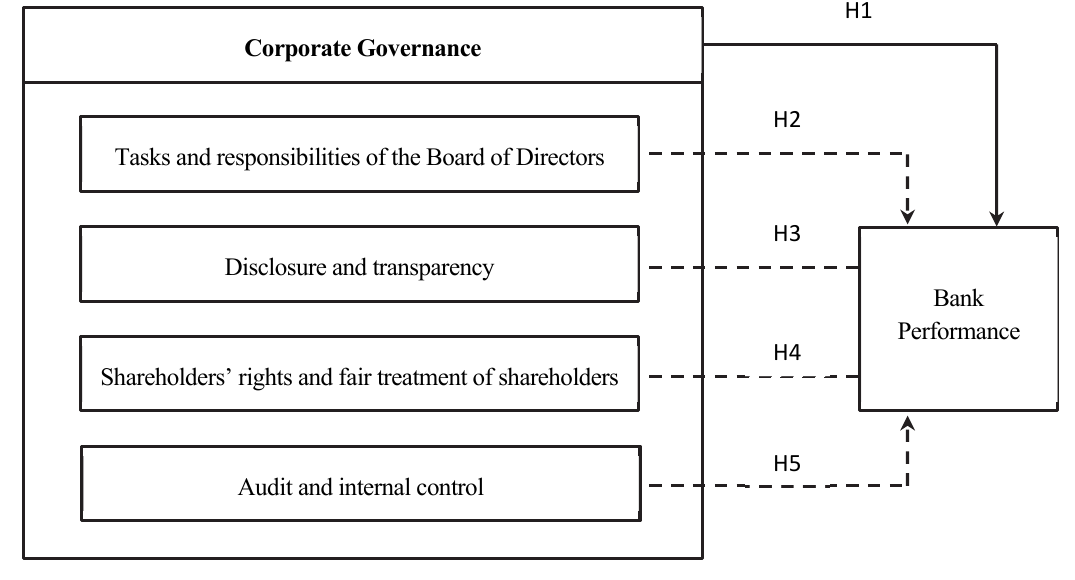
Fig. 2. Research conceptual model